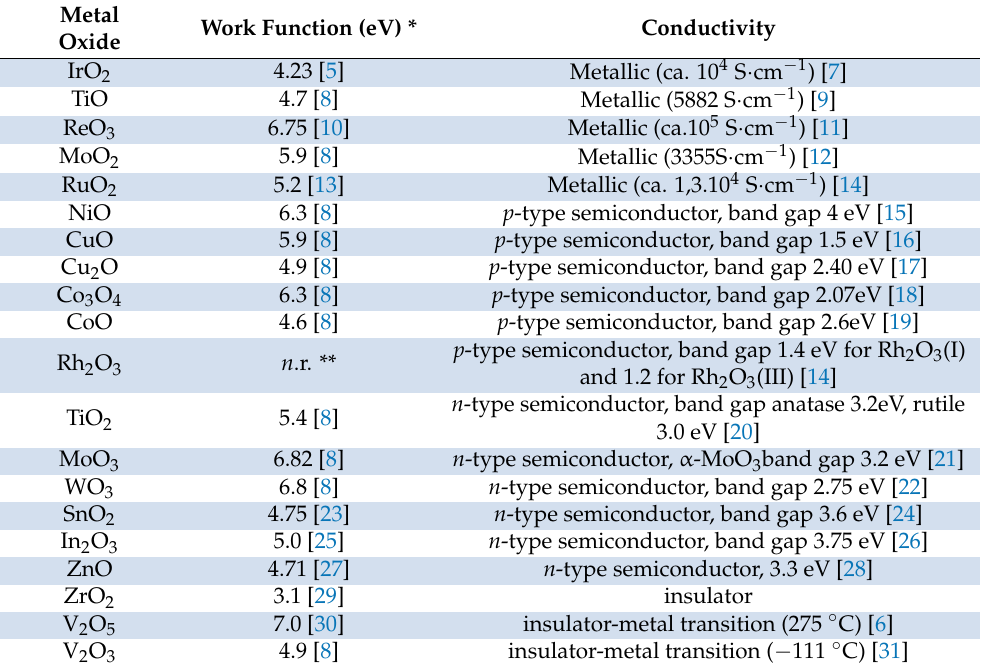
Table 1. Work functions and conductive characteristics of some